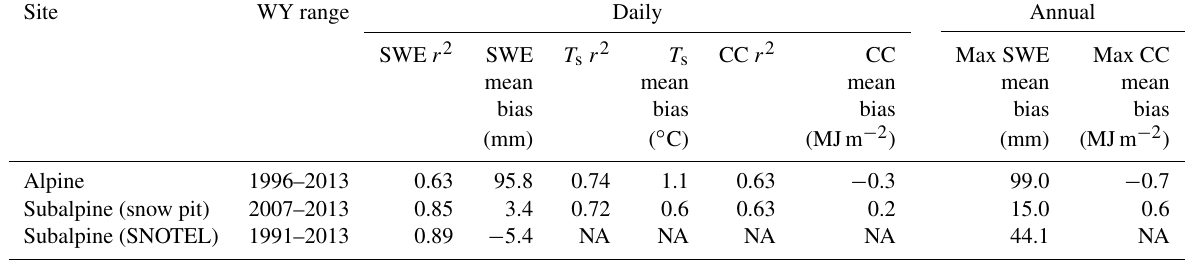
Table 2. Statistics for SNOWPACK simulations relative to daily and annual observations from the snow pits in the alpine and subalpine, and Niwot SNOTEL in the subalpine. There is no SNOTEL station in the alpine and SNOTEL does not observe cold content and snowpack temperature. Comparisons are for the water years listed in the second column.